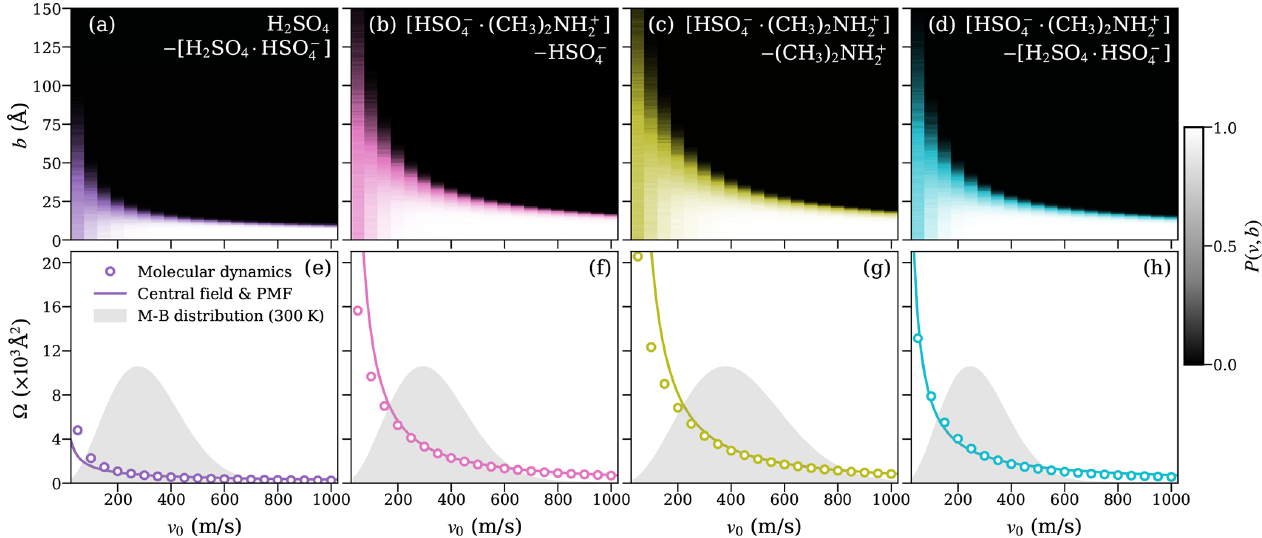
Figure 5. Heat maps of the collision probabilities from molecular dynamics (MD) for ion–dipole systems, including at least one dimer as a function of initial relative velocity v 0 and impact parameter b ( a–d ; top row). Corresponding dynamic collision cross sections (cid:127) MD ( v ) are obtained from these MD collision probabilities, using Eq. (15) (open circles), and collision cross sections (cid:127) CF ( v ) based on the central field model (solid lines), using an attractive interaction fitted to the PMF according to Eq. (5) ( e–h ; bottom row). The Maxwell–Boltzmann distribution of the relative velocity for each system is indicated by the gray